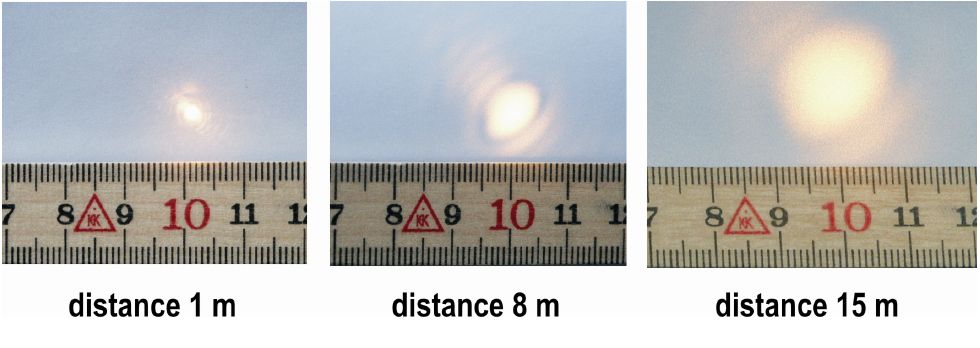
Figure 5. Distribution of light intensity inside the laser beam for three measuring